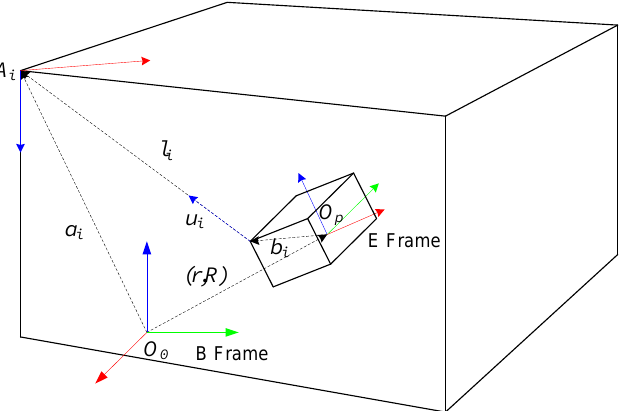
Figure 2. Kinematics of the moving platform of a cable robot.